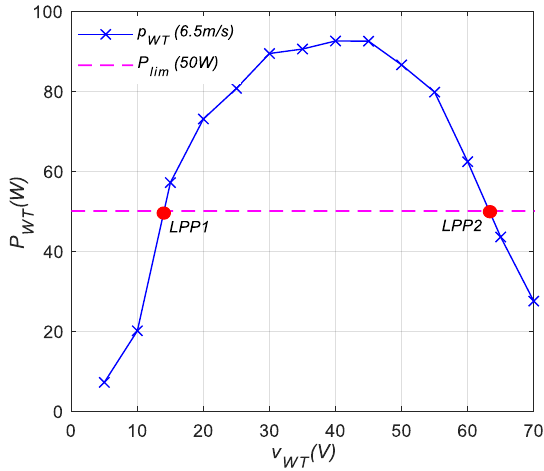
Figure 8. for selected wind speed. Figure 8. p WT based on v WT for selected wind